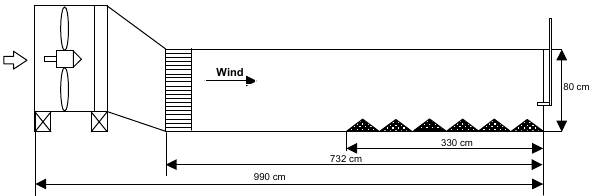
Fig. 2. Schematic view of the wind tunnel with the location of the tested sample.